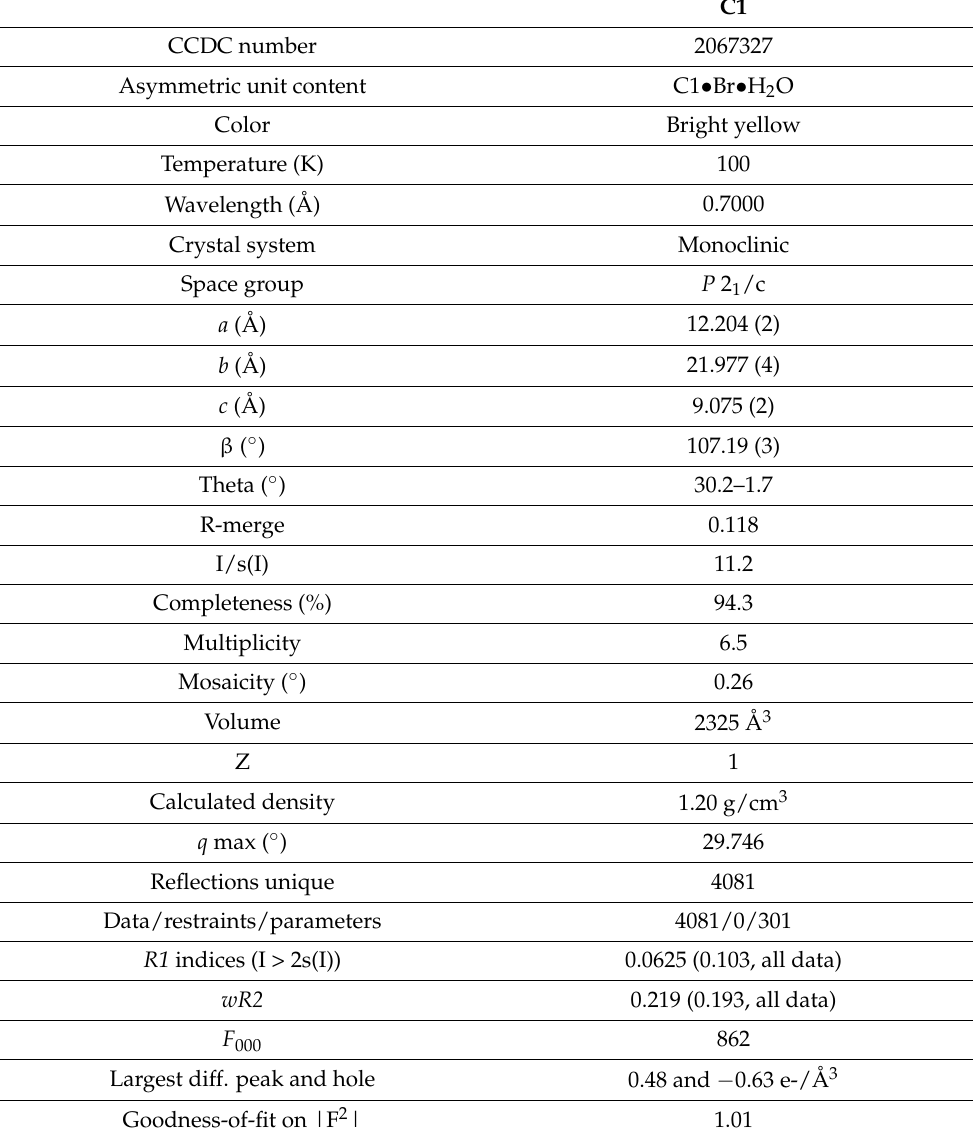
Table 5. Data collection and refinement statistics of C1